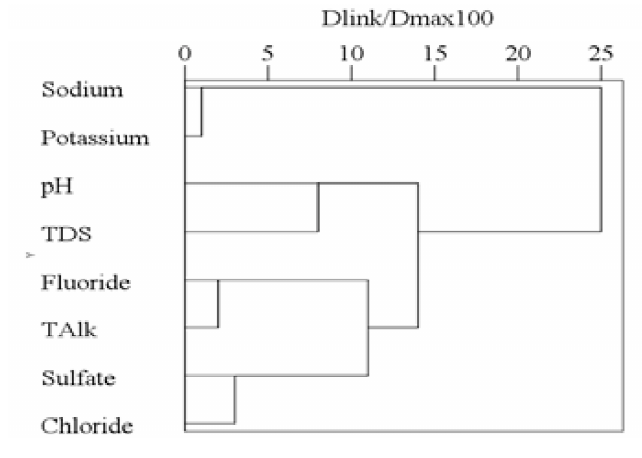
Figure 7. R-Cluster analysis results.